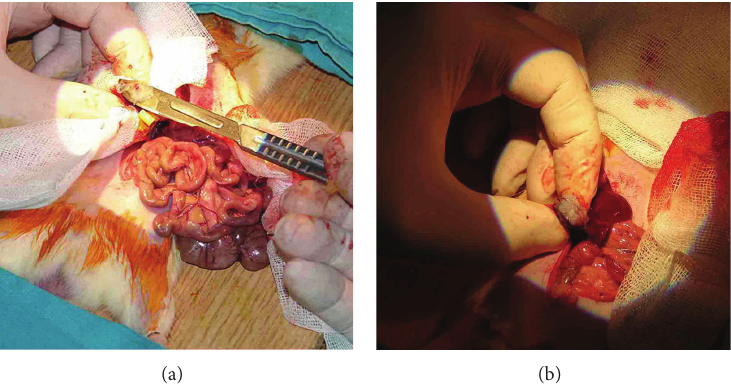
Figure 6: (a) and (b) Application of the ABS Nanohemostat on the resected area.